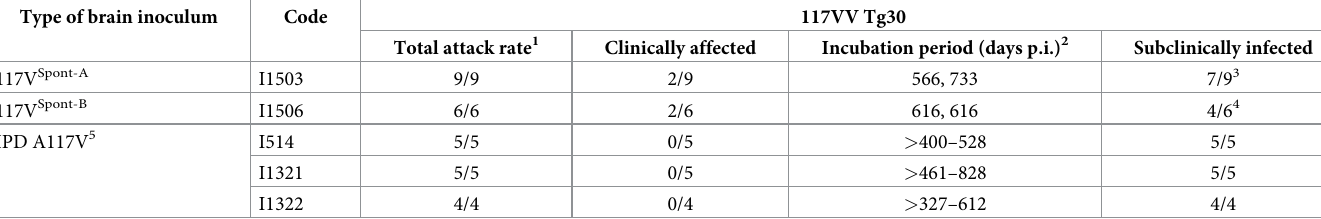
Table 1. Primary transmission of spontaneous 117V prion isolates and IPD A117V patient brain to 117VV Tg30 mice. Type of brain